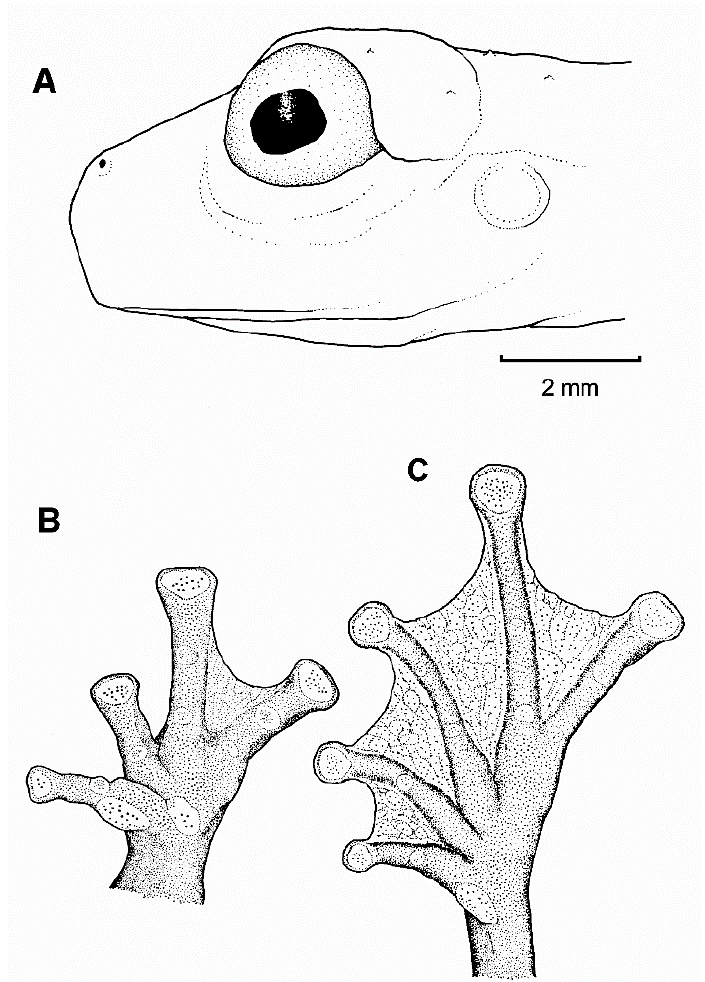
Figure 191. Rulyrana flavopunctata . ( A ) Head in lateral view, holotype, adult male, KU 121046. ( B ) Hand in ventral view, KU 121050. ( C ) Foot in ventral view, KU 121048. ( B , C ) Modified from Lynch and Duellman